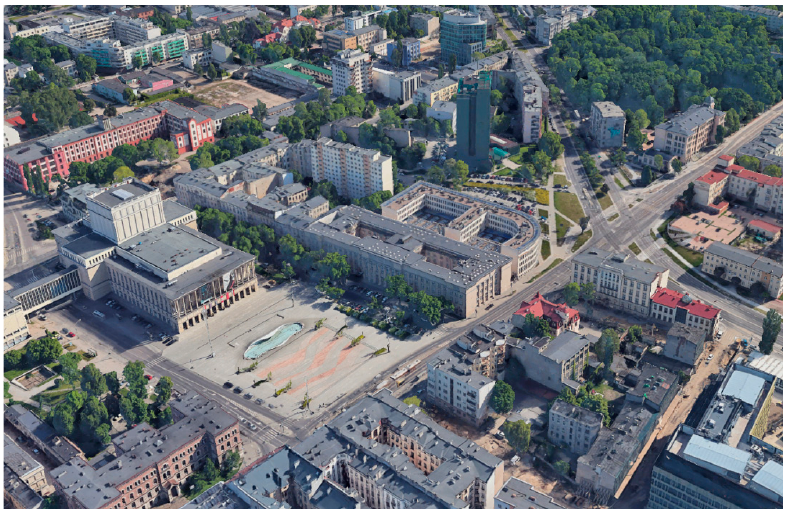
Figure 13. The contemporary landscape of D ą browskiego Square in Ł ód ź . Source: https://earth.google.com/, accessed on 12 February 2022.